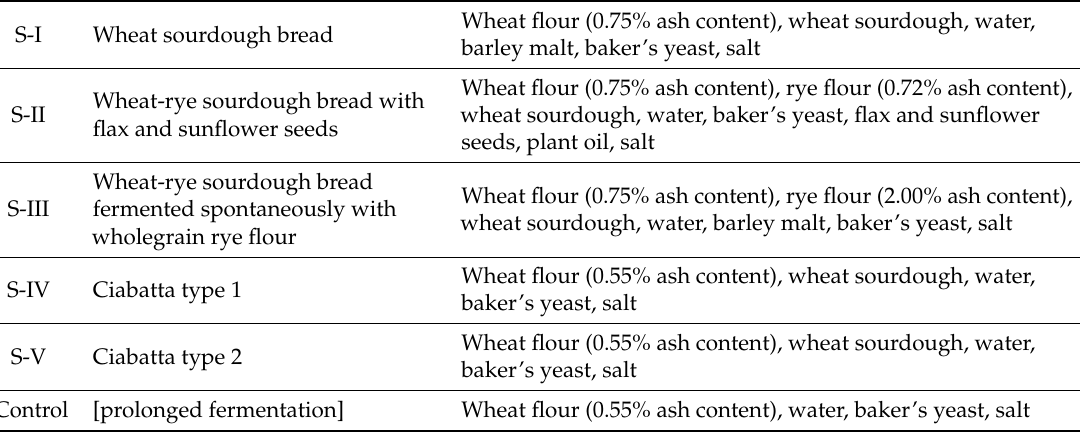
Table 1. Analyzed samples of wheat sourdough bread.